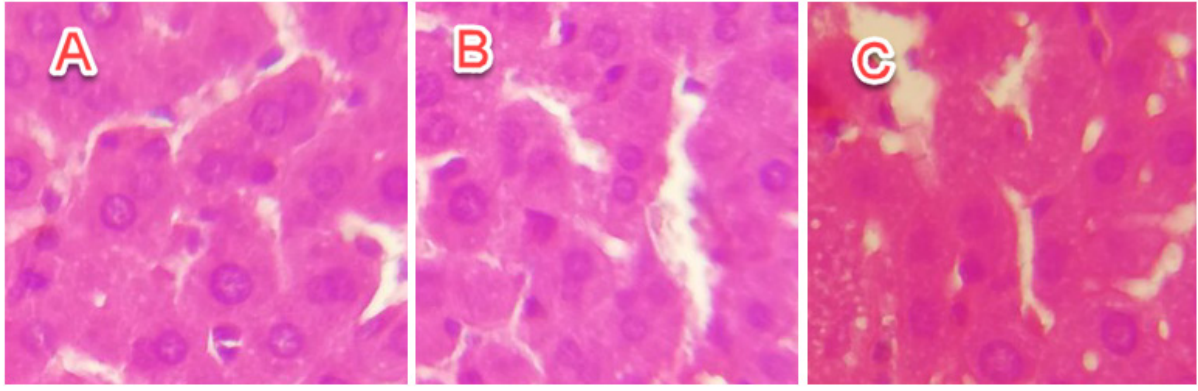
Figure 4 : Histologic section of kidney tissue of the control mice. (Section stained with H&E, x 40) A, B, and C are sections of the kidney tissue of three mice taken from the control group.